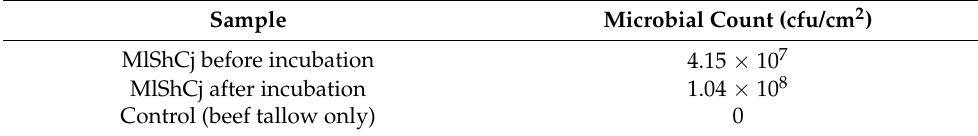
Table 4. Microbial counts on the sample (textile) before and after